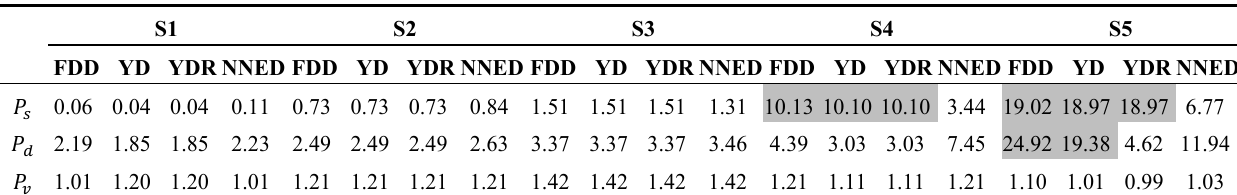
Table 2. RMSE of each decomposition method for the range slope variation. Shaded cells represent that a range profile of the calculated scattering component contains negative power. S1 S2 S3 S4